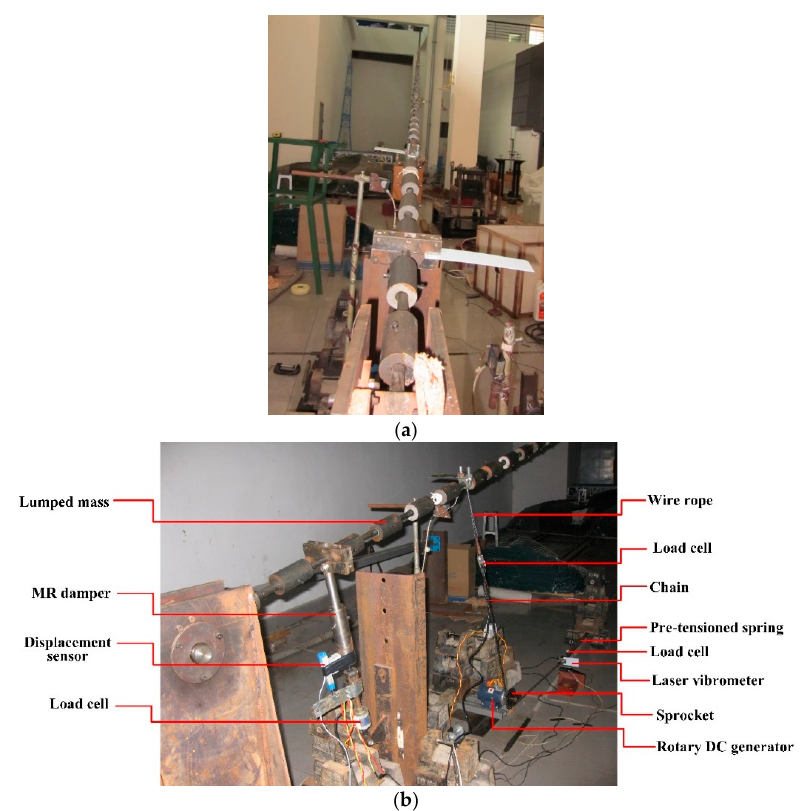
Figure 7. General layout of the experimental setup for cable vibration control.